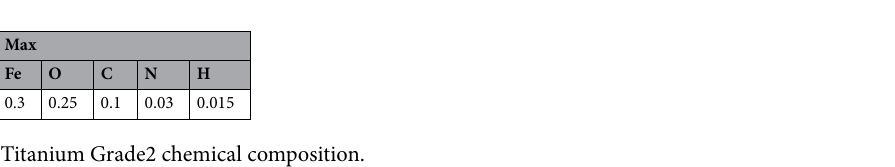
Figure 1. Graphical overview.